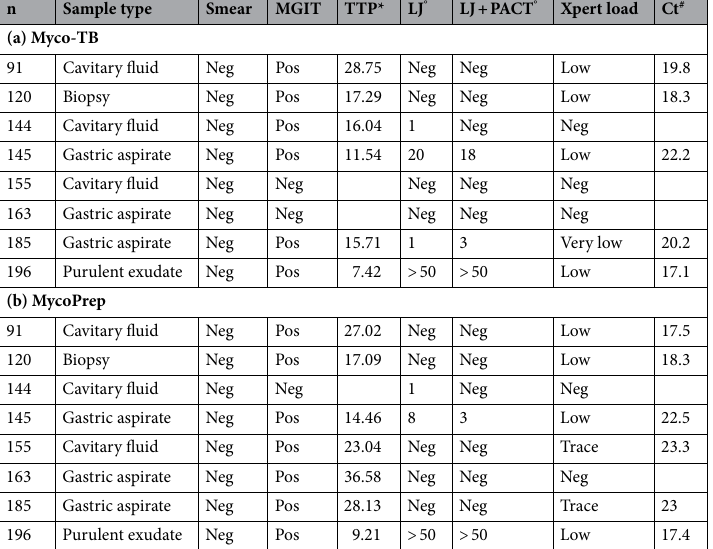
Table 2. Microbiological characteristic of MTBc-positive samples obtained after decontamination with (a) Myco-TB and (b) MycoPrep. *TTP = Time to positivity. ° number of Mycobacteria colonies. Neg = negative. Pos = positive. # Ct: Cycle threshold values referred to IS6110/IS1081